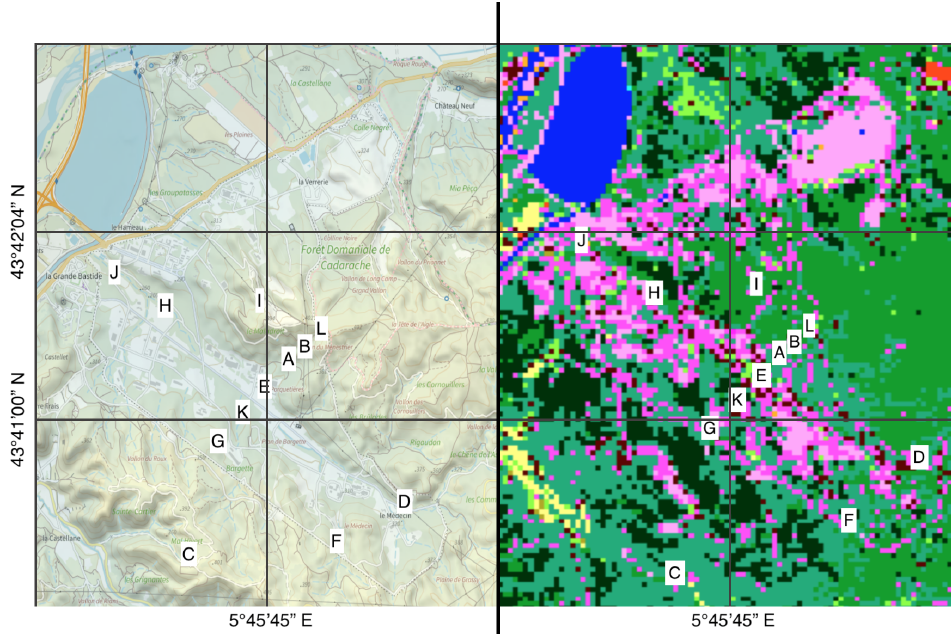
Figure 2. On the ( left ) is a map of the Cadarache Valley and on the ( right ) is the equivalent land-use map. Each contour level represents a 20 m change in elevation. On the land-use map, green shades indicate vegetation, pink shades indicate buildings and roads, and blue indicates water. The letters show the LEMS stations, which are described in Section 3. The map on the left is modified, and the original is from https://www.geoportail.gouv.fr/carte, accessed on 9 October 2021. The land-use map on the right is modified, and the original is from https://theia.cnes.fr, accessed on 9 October